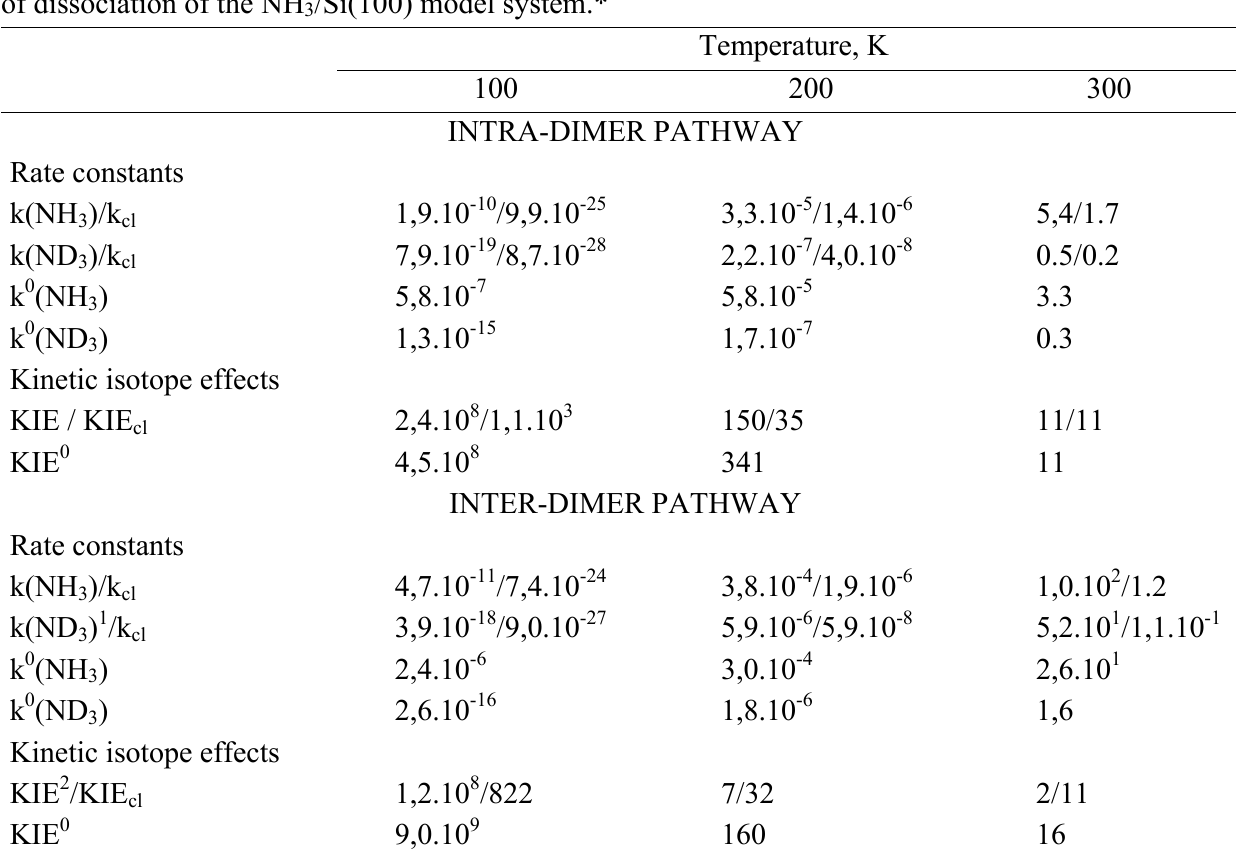
)/k(ND ) for the two pathways 3 3